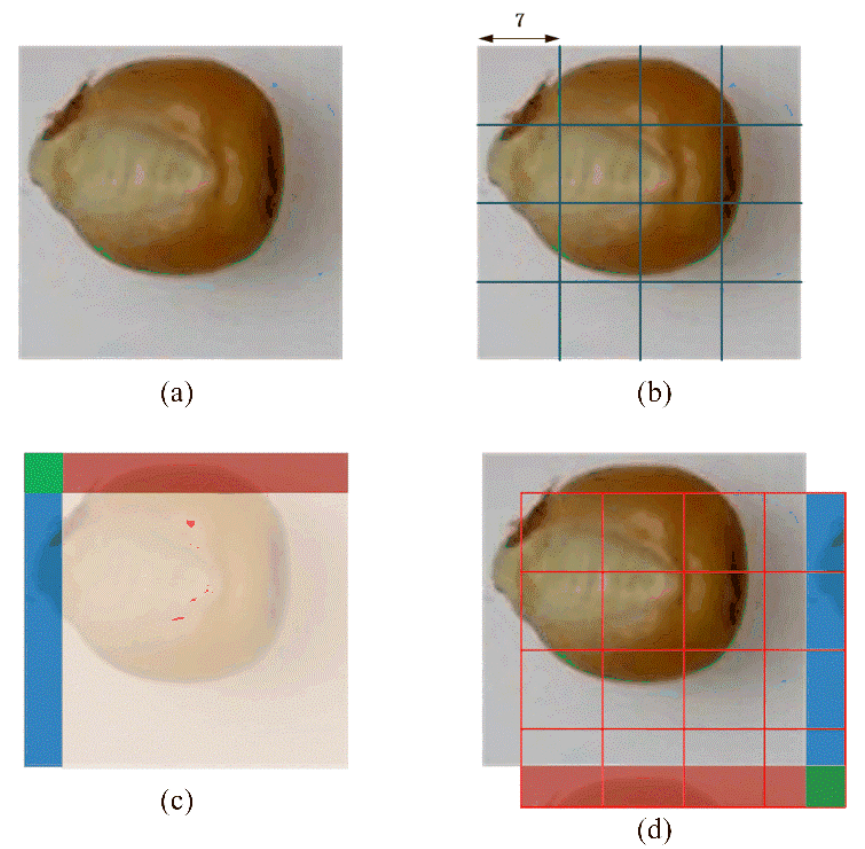
Figure 10. ( a ) Input image ( b ) Window segmentation of input image through W-MSA ( c ) Operation of moving window ( d ) Different window segmentation methods through SW-MSA.